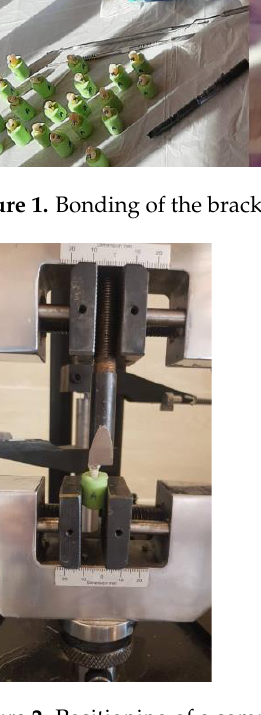
Figure 1. Bonding of the bracket to the enamel surface.